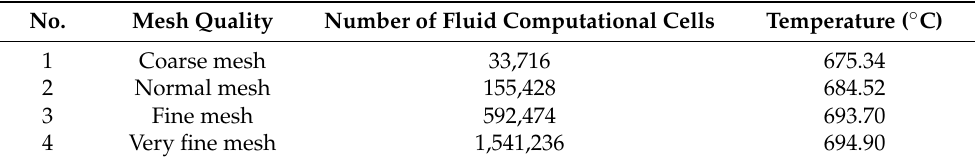
Table 3. Results of numerical grid refinement